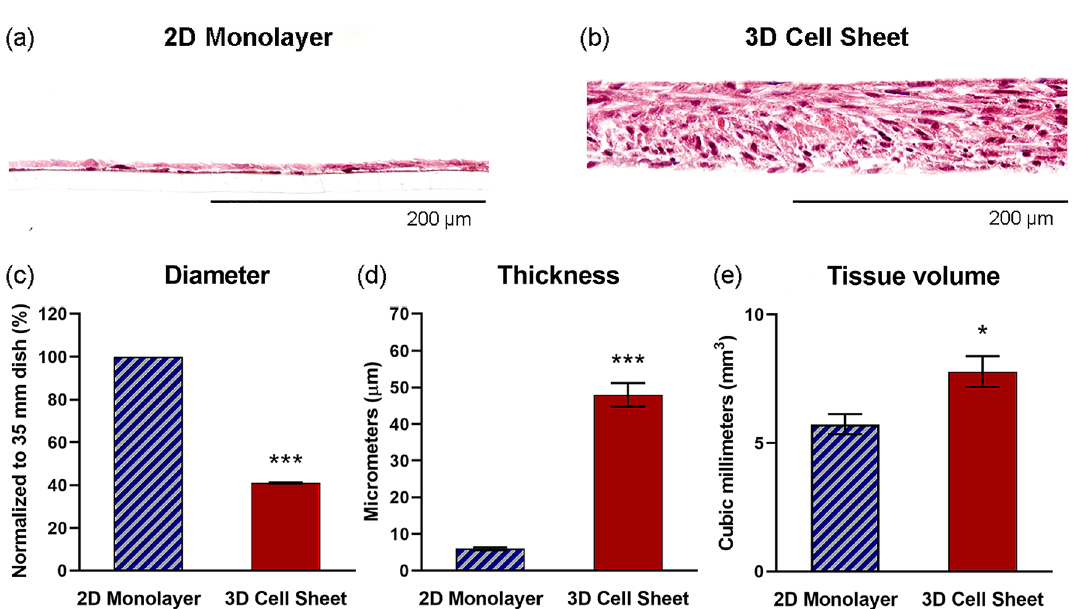
Figure 2. Spontaneous cell sheet contraction contributes a 3D tissue-like structure. Cross-sectional visualization of ( a ) 2D monolayer and ( b ) 3D cell sheet tissue structure with H&E stain. Quantified comparison of 2D monolayer and 3D cell sheet ( c ) diameter, ( d ) thickness, and ( e ) volume. Scale bars = 200 μm. Values are means ± SE (n = 10 (diameter), n = 3 (thickness): * p < 0.05, *** p <